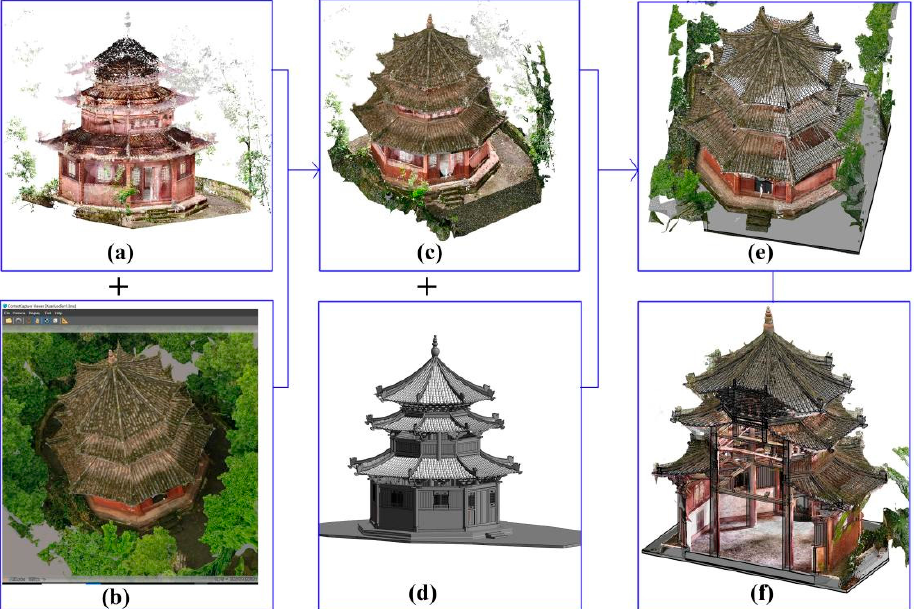
Figure 19. The Digital Twin modeling progress: ( a ) Point cloud model from LAS with an incomplete roof. ( b ) The model with an insufficient structure below the eaves from photogrammetry. ( c ) Complete point cloud of the Xuanluo Hall. ( d ) BIM model of Xuanluo Hall. ( e ) Point cloud with BIM model. ( f ) The section of point cloud with BIM model.